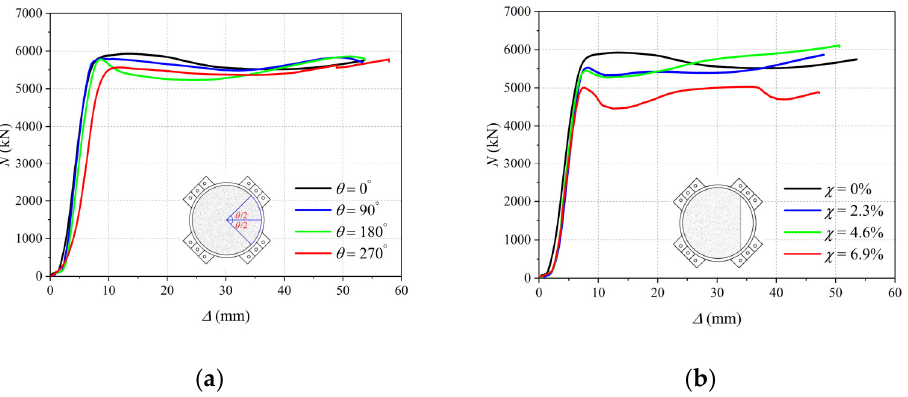
Figure 8. N - Δ curves of BWCFST specimens with different initial imperfections: ( a ) BWCFST with interfacial gap; ( b ) BWCFST with spherical-cap gap.